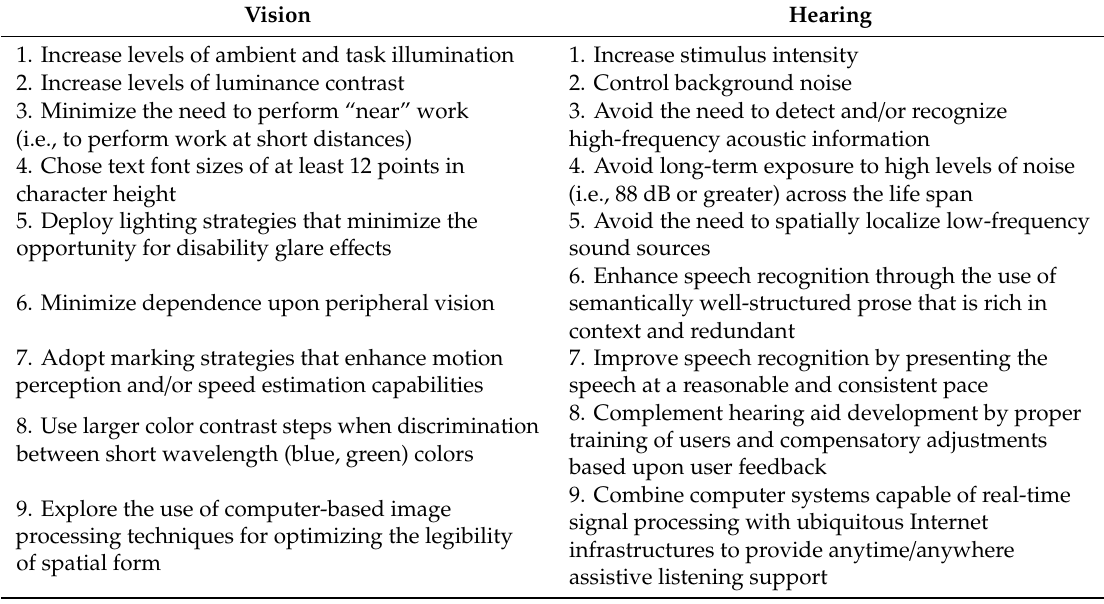
Table 1. Measures for compensating age-related deficits in sensory and cognitive functions